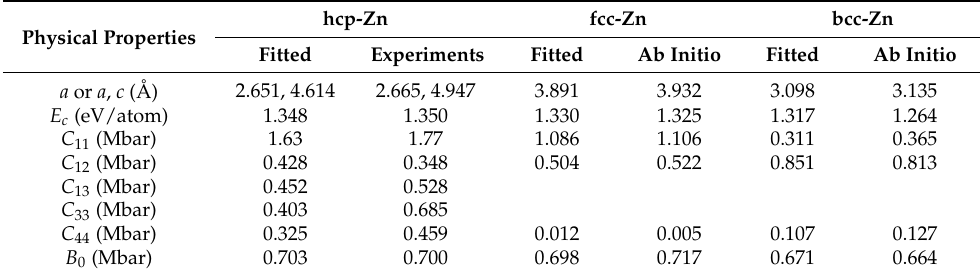
Table 2. The physical properties (bulk modulus ( B 0 , Mbar), elastic constants ( C ij , Mbar), cohesive energies ( E c , eV), and lattice constants ( a , c (Å)) of hcp-Zn, fcc-Zn, and bcc-Zn, fitted using the potential and obtained from experiments [39,40] or ab initio calculations.